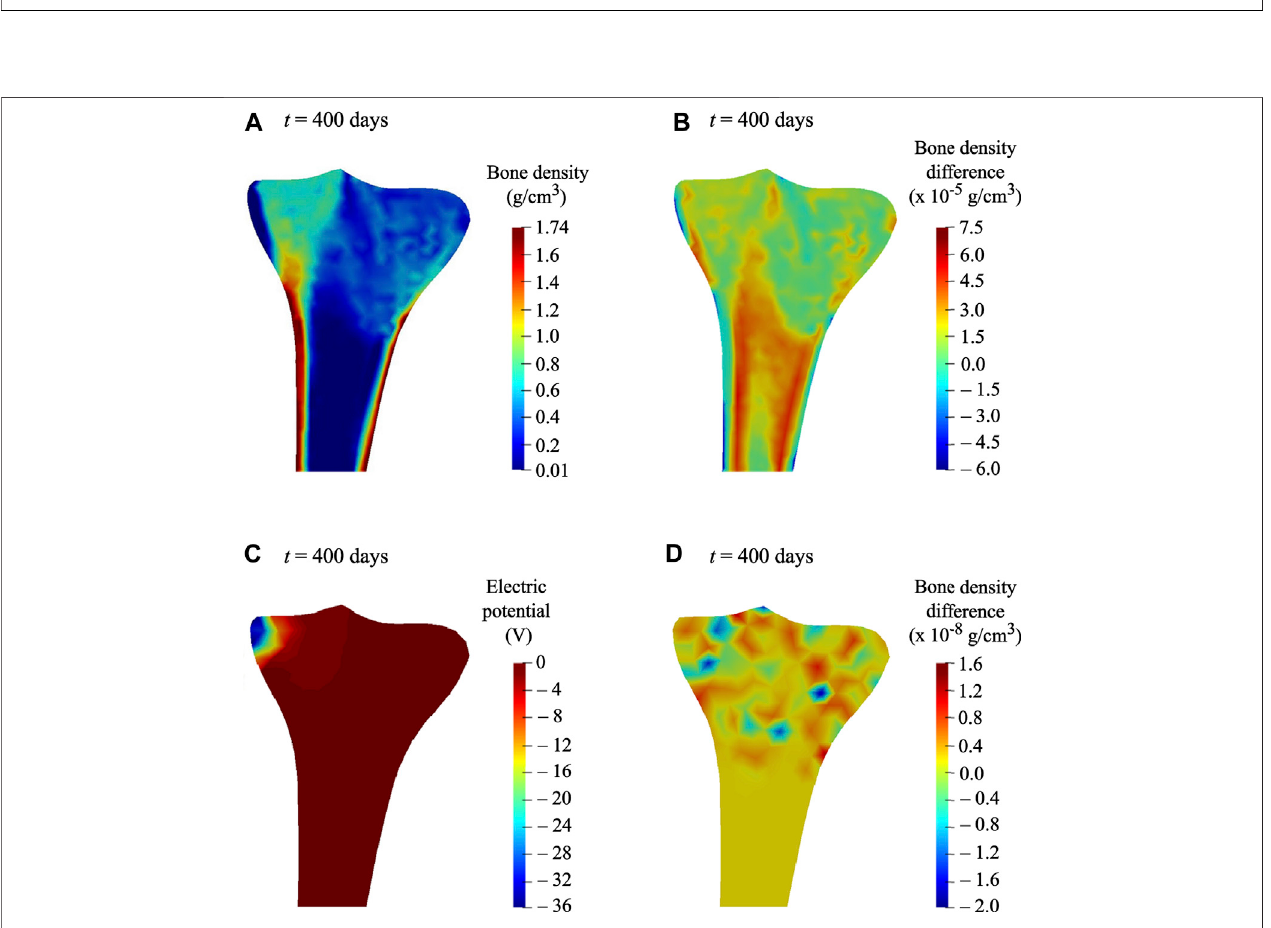
FIGURE 11 | (A) Predicted bone density distribution after the reduced physical activity period ( t (cid:1) 400 days). (B) Differences in predicted bone density, after the remodelingperiod( t (cid:1) 300 days)andafterthereducedphysicalactivityperiod( t (cid:1) 400 days). (C) Electricpotentialgeneratedattime t (cid:1) 400 days,whenasurfaceelectric charge was applied to the medial condyle for the reduced physical activity period (i.e., 300 – 400 days). (D) Differences in predicted bone density at time t (cid:1) 400 days, when therapeutic electrical stimulation was applied along with acting mechanical loads and when only mechanical loads were acting.